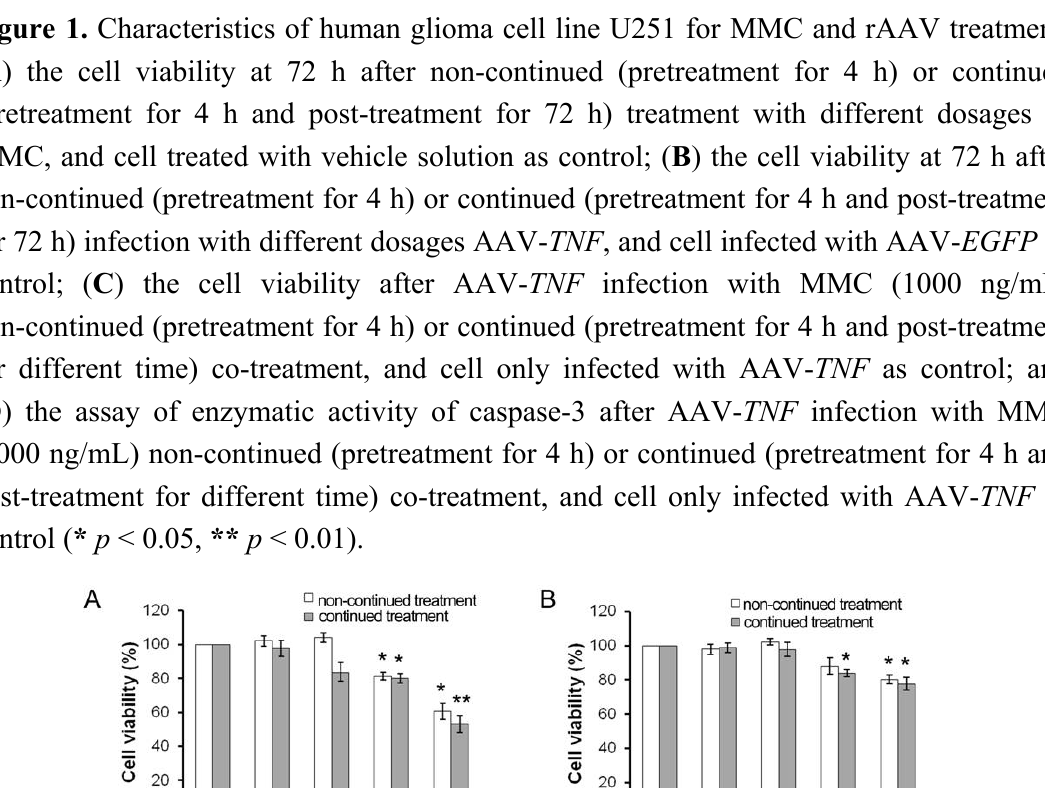
Figure 1. Characteristics of human glioma cell line U251 for MMC and rAAV